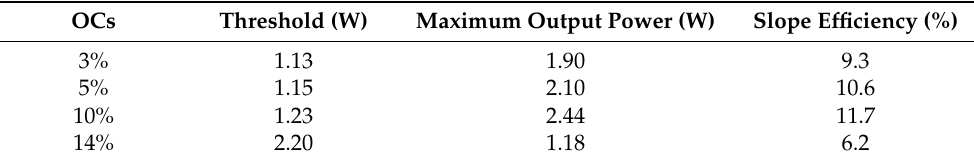
Table 1. Maximum output power, slope efficiency, and laser threshold for the Tm:LuAG SCF.